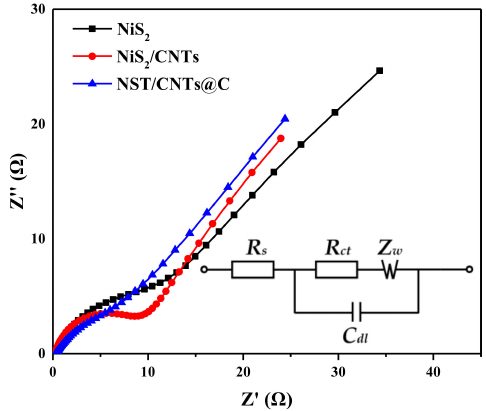
Figure7. NyquistplotsofNiS 2 ,NiS 2 / CNTsandNST /